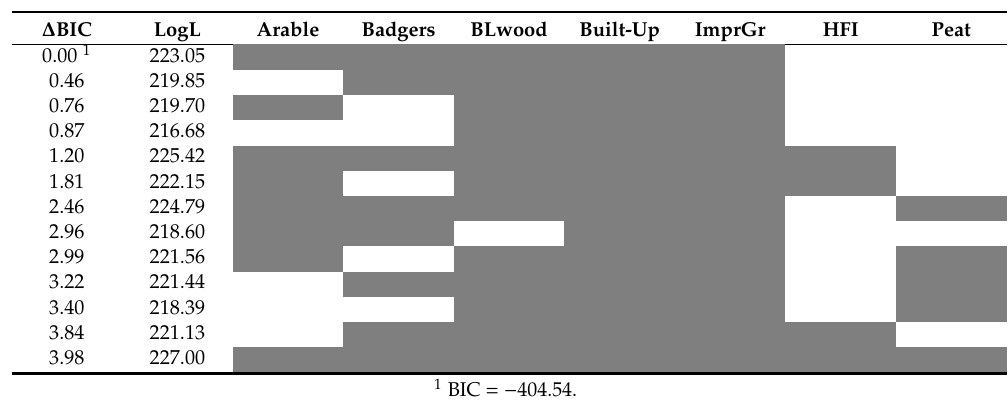
Table 3. Top-performing models with ∆ BIC < 4 from a multi-model selection consisting of all possible explanatory variables. Shaded areas indicate that the variable was included in the model. All model variables had VIFs < 2. LogL is the log-likelihood, Arable is Arable Horticulture, Badgers is the likelihood of badger presence, BLwood is broadleaved woodland, ImprG is improved grasslands, HFI is human footprint index, and Peat is soils with a peaty texture.